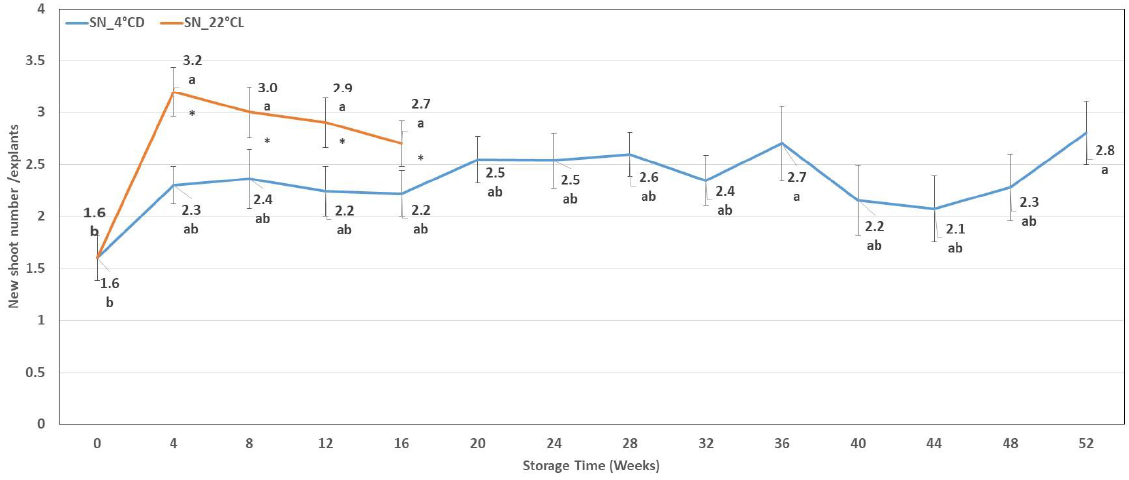
Figure 2. Number of newly developed shoots (SN) during cold storage (SN_4 ◦ CD) and during storage in the growth chamber (SN_22 ◦ CL). Line graphs present mean values ± SE of SN. Lower case indicates the significant differences between the SN measured after different storage times. * indicates the significant differences between the SN measured after different storage conditions.